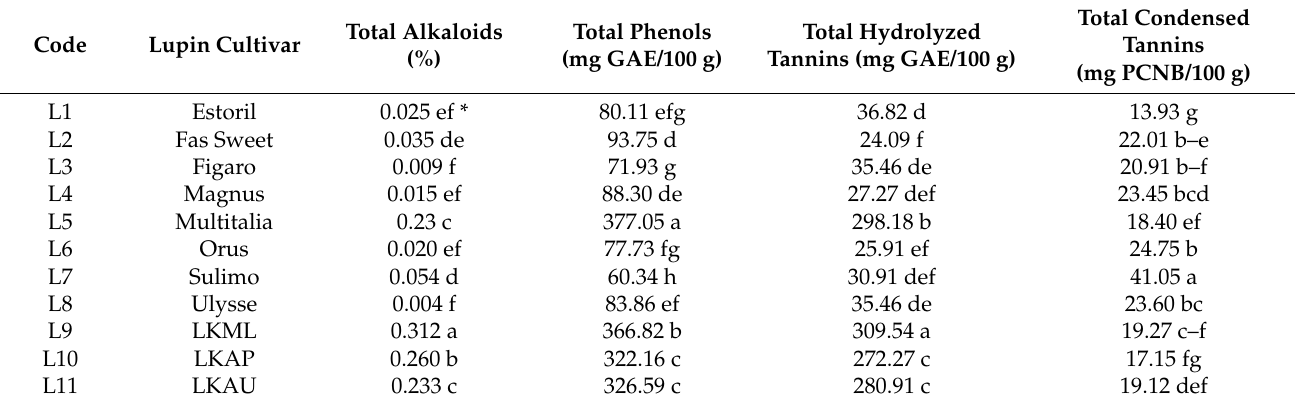
Table 6. Antinutritional traits of lupin cultivars and advanced